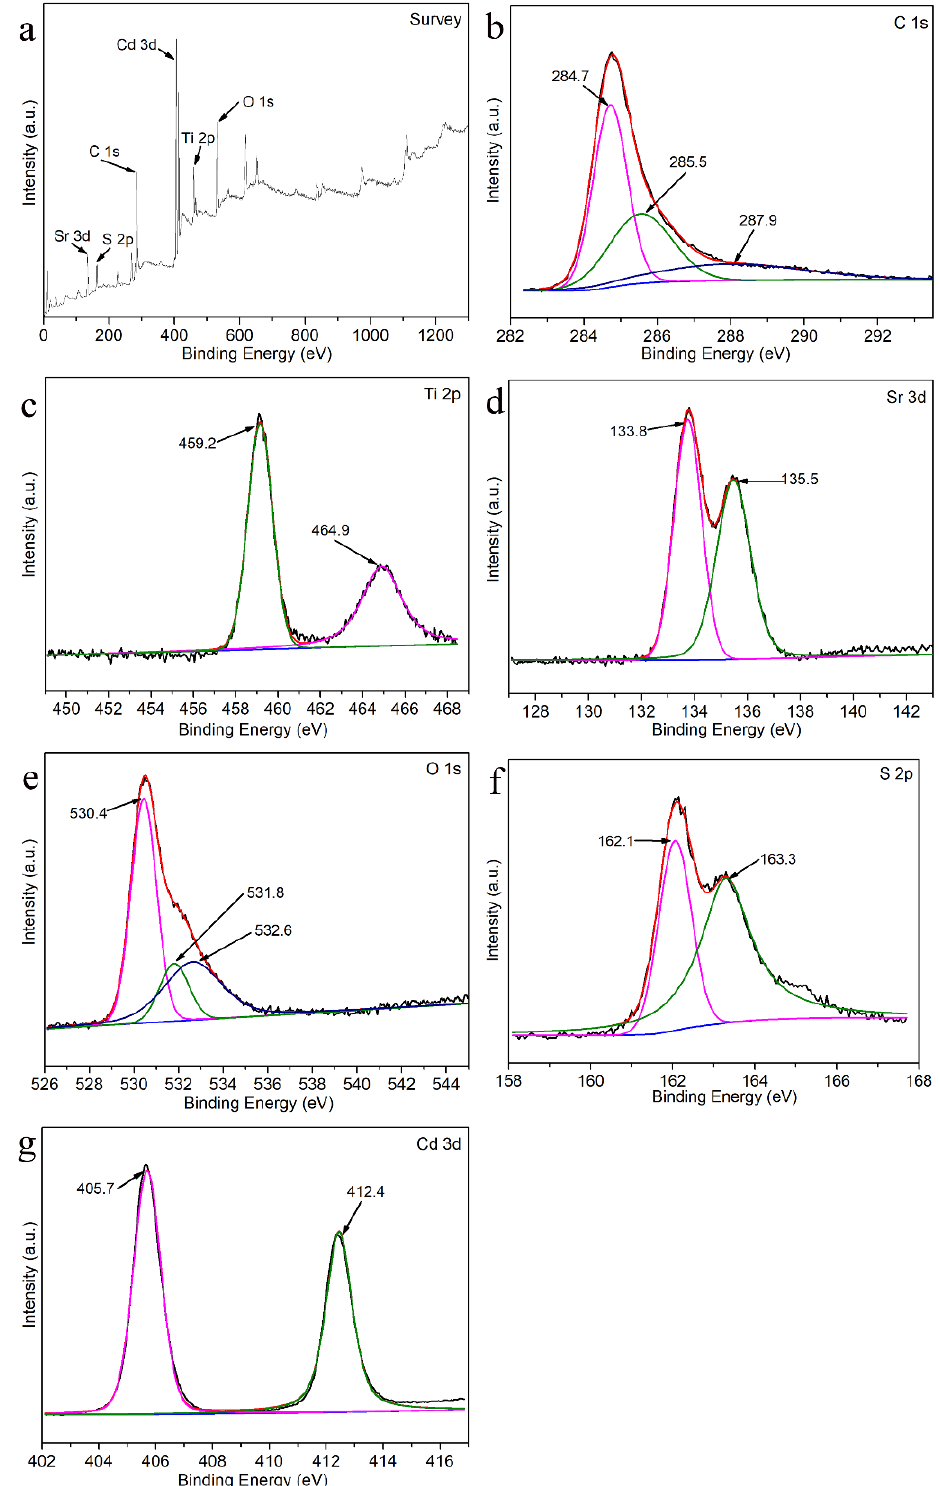
Figure 4. XPS spectra of CF/SrTiO 3 /CdS: ( a ) full spectrum, ( b ) C 1s spectrum, ( c ) Ti 2p spectrum, ( d ) Sr 3d spectrum, ( e ) O 1s spectrum, ( f ) S 2p spectrum, and ( g ) Cd 3d spectrum.